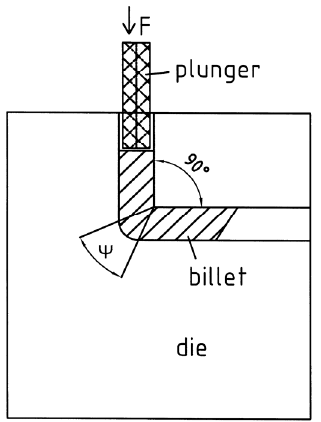
Figure 1: Principle of ECAP